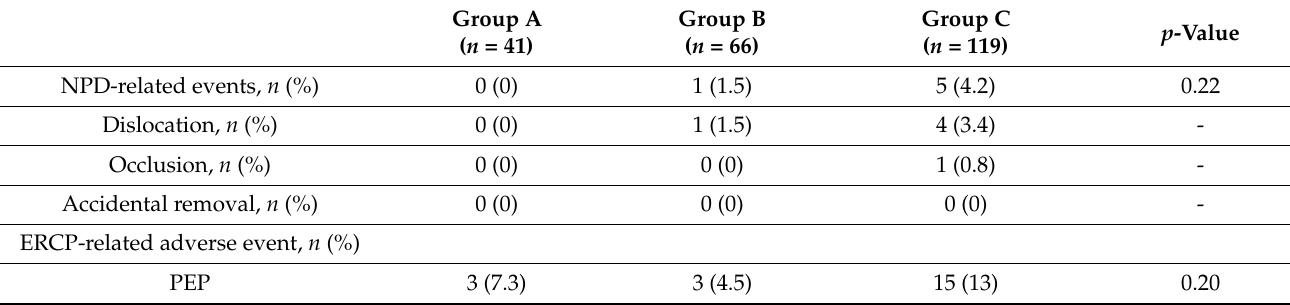
Table 4. Adverse events of